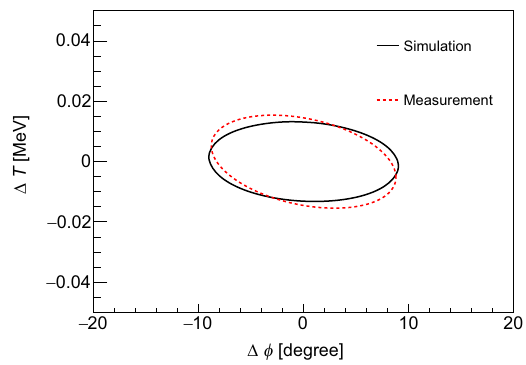
FIG. 17. Comparison between the measured longitudinal Twiss ellipses and the simulation at the RFQ exit. Δ ϕ and Δ T are the displacement of the longitudinal phase and that of the energy from the mean,